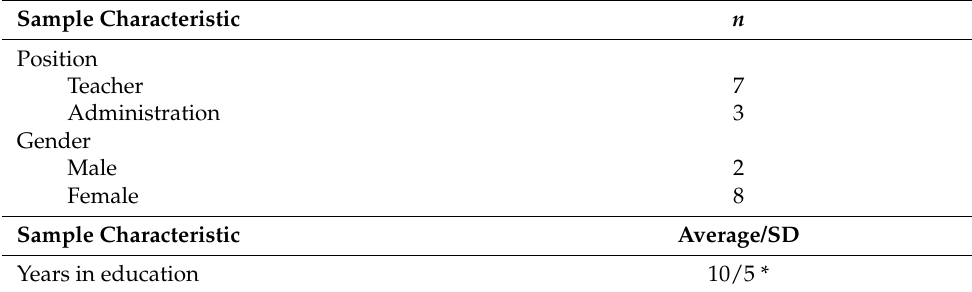
Table 2. Sample information for the interview